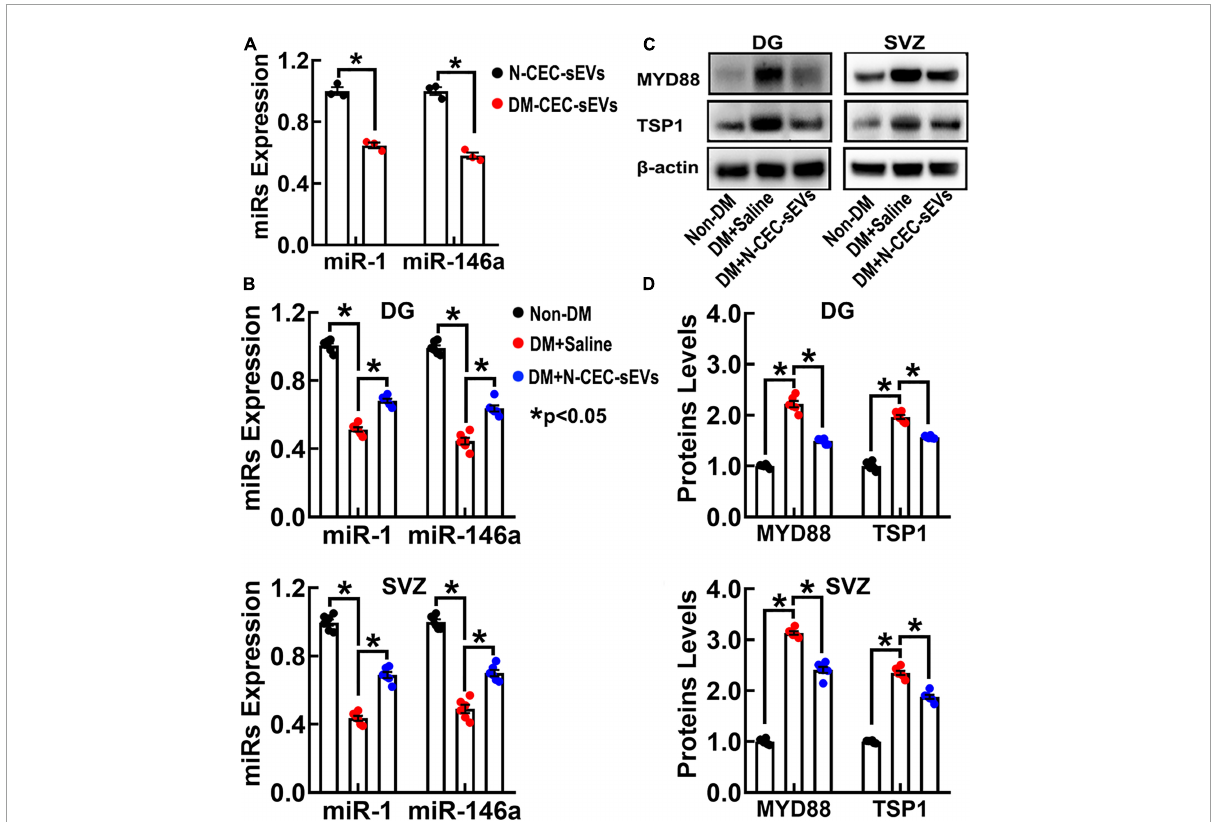
FIGURE8 N-CEC-sEV treatment elevates miR-1 and –146a, and reduces MYD88 and TSP1 expression in DG and SVZ tissues isolated from aged-DM rats. Quantitative RT-PCR data show miR-1 and –146a levels in N-CEC-sEVs and DM-CEC-sEVs (A) and in DG and SVZ tissues (B) isolated from age-matched non-DM rats, and aged-DM rats treated with saline and N-CEC-sEVs. Representative Western blots (C) and quantitative data (D) of MYD88 and TSP1 levels in the DG and the SVZ. Data are presented as fold change from the non-DM group. * p < 0.05 versus indicated